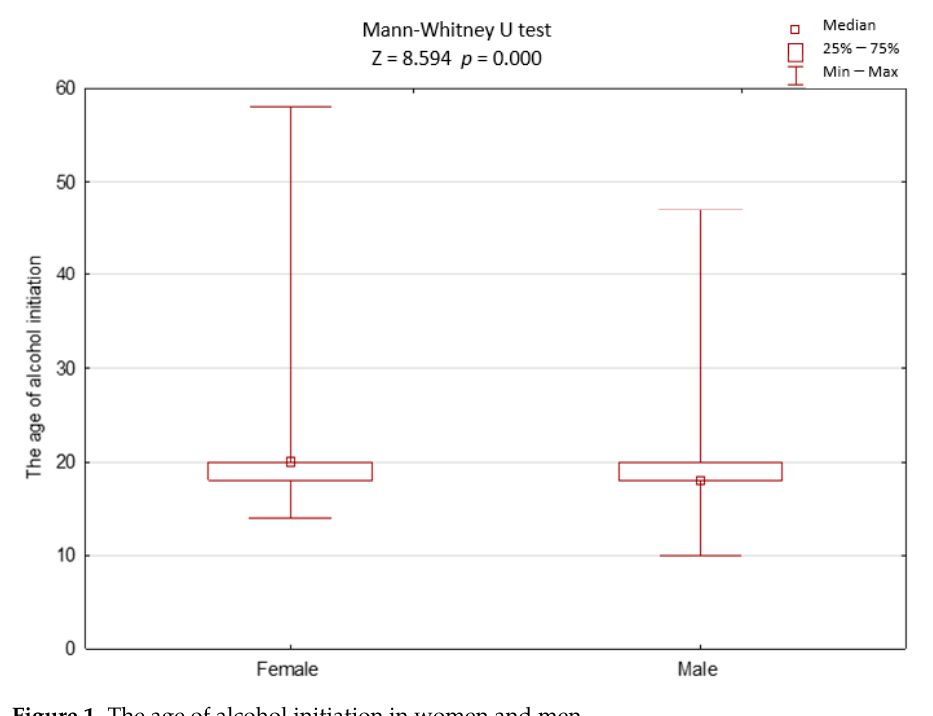
Figure 1. The age of alcohol initiation in women and men.